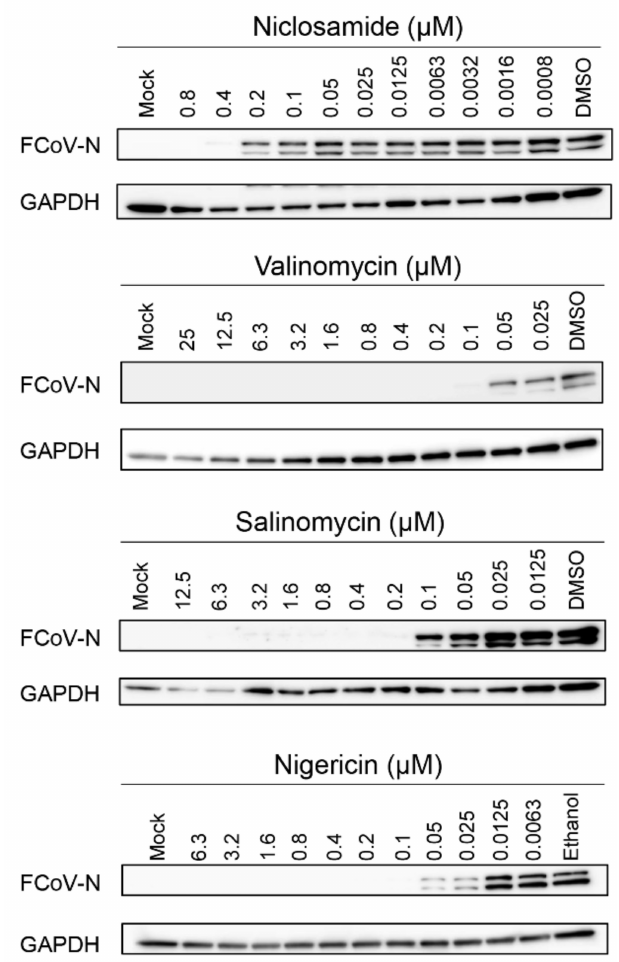
Figure 2. Ionophore antibiotics inhibit FCoV replication in a dose-dependent manner by Western blot analysis. The Fcwf-4 cells were incubated with ionophore antibiotics or an equivalent volume of each solvent after infection with FCoV in the presence of the antibiotics and niclosamide. At 20 h after infection, the cells were lysed with cell lysis buffer and assessed by Western blot analysis. FCoV, feline coronavirus; Fcwf-4, Felis catus whole fetus-4; GAPDH, glyceraldehyde-3-phosphate dehydrogenase; FCoV-N, feline coronavirus